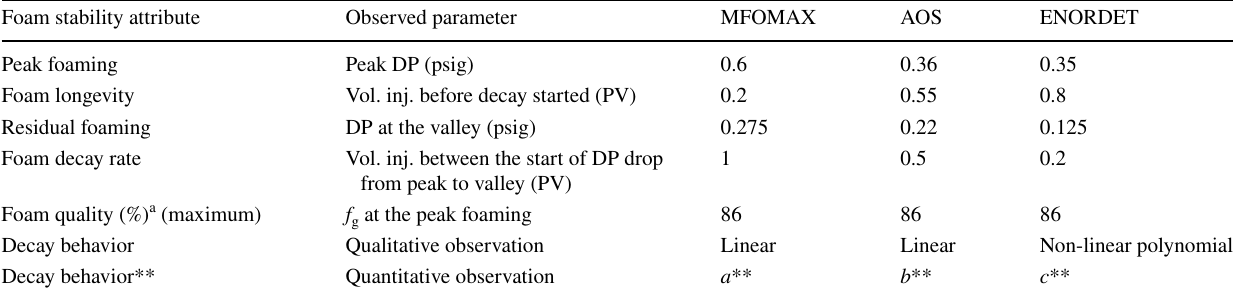
Table 8 Summary of coreflood